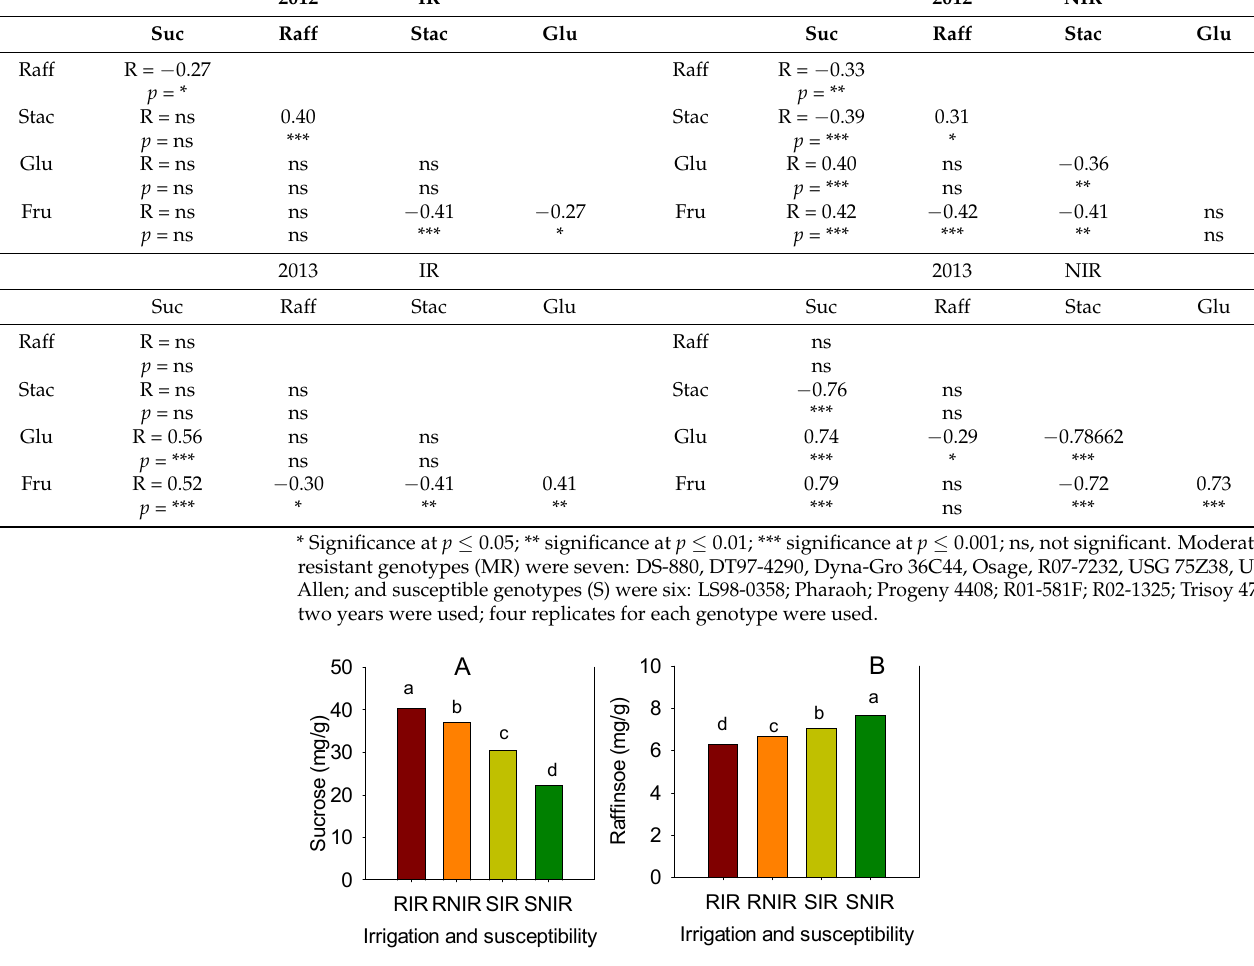
Table 6. Pearson correlation coefficients (R) and their probability ( p ) between seed sugars (sucrose (Suc, mg/g), raffinose (Raff, mg/g), stachyose (Stac, mg/g), glucose (Glu, mg/g), and fructose (Fru, mg/g)) for 2012 and 2013 across soybean genotypes and within irrigation treatments. The experiment was conducted in 2012 in Jackson, TN, USA. IR NIR